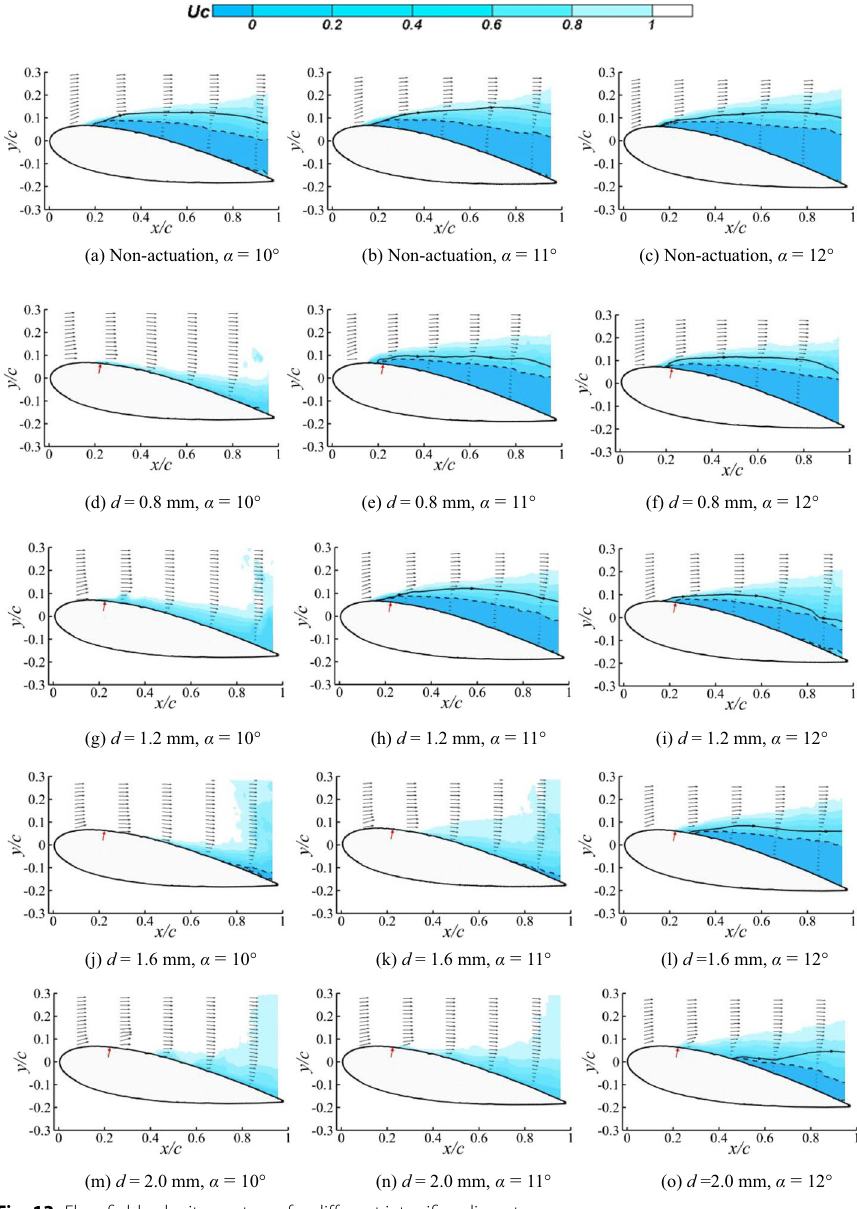
Fig. 13 Flow field velocity contours for different jet orifice